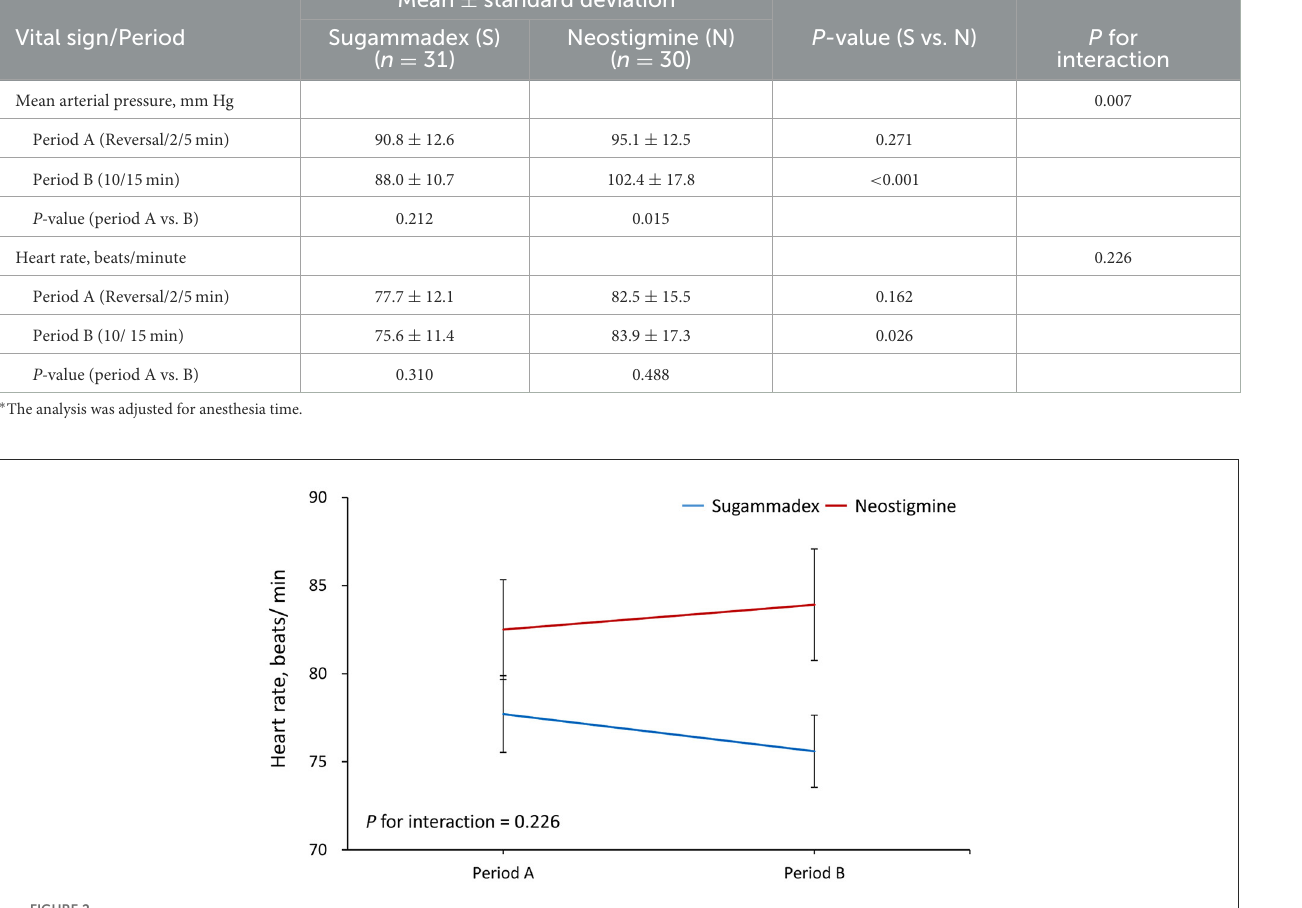
FIGURE2 Changes in heart rate from period A to B. Period A was defined as the average from reversal, and both 2 and 5min after reversal. Period B was defined as the average from 10 to 15min after